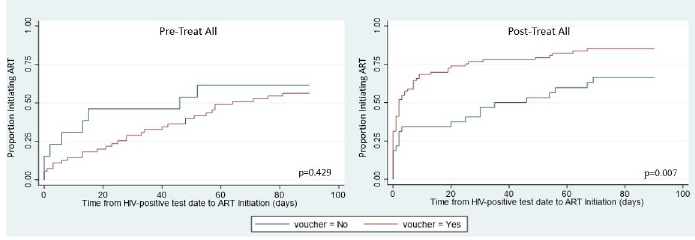
Fig 1. Kaplan-Meier curves for time to ART initiation by voucher status: Pre and post-Treat All.